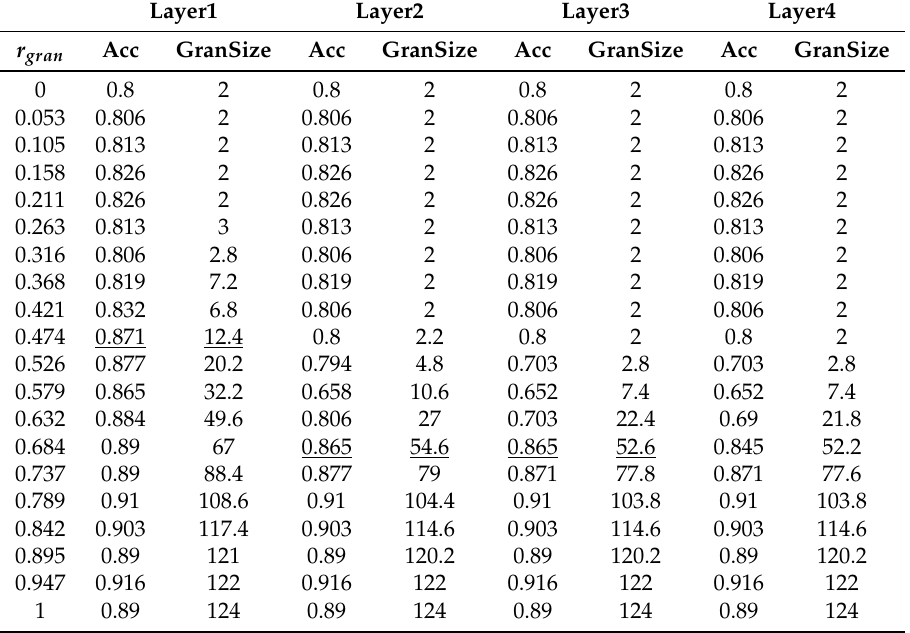
Table 19. CV-5; Result of experiments for multi-layer c-d granulation with use of kNN classifier; data set Hepatitis; r gran = Granulation radius, Acc = Average accuracy for the considered layer, TRNsize The mean size of granular decision system for the considered